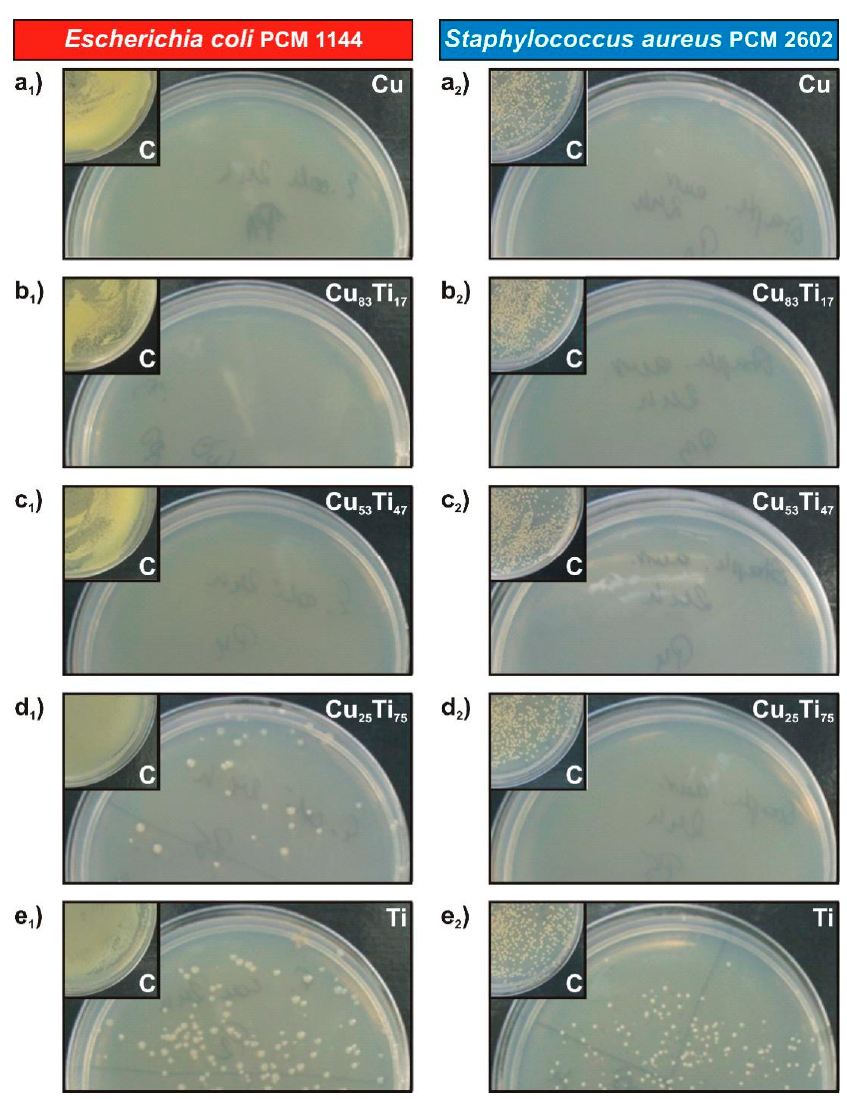
Figure 5. Antimicrobial activity of thin films based on Cu and Ti against (1) E. coli (PCM1141) and (2) S. aureus (PCM 2602), after 24 h exposure in contact with: ( a ) Cu, ( b ) Cu 83 Ti 17 , ( c ) Cu 53 Ti 47 , ( d ) Cu 25 Ti 75 , and ( e ) Ti. In the inset of each picture, a result for the control sample (incubation without contact with the film surface) is